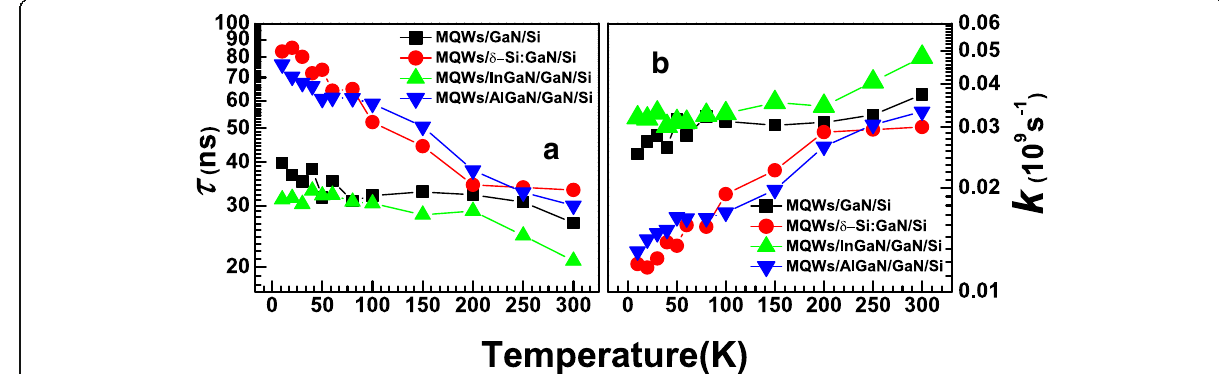
Fig. 4 a PL lifetimes vs. temperature for S1 – S4. The detected wavelength is kept at each peak position according to SSPL results in Fig. 2. b Corresponding recombination rates for S1 – S4, which are obtained by k = 1/ τ